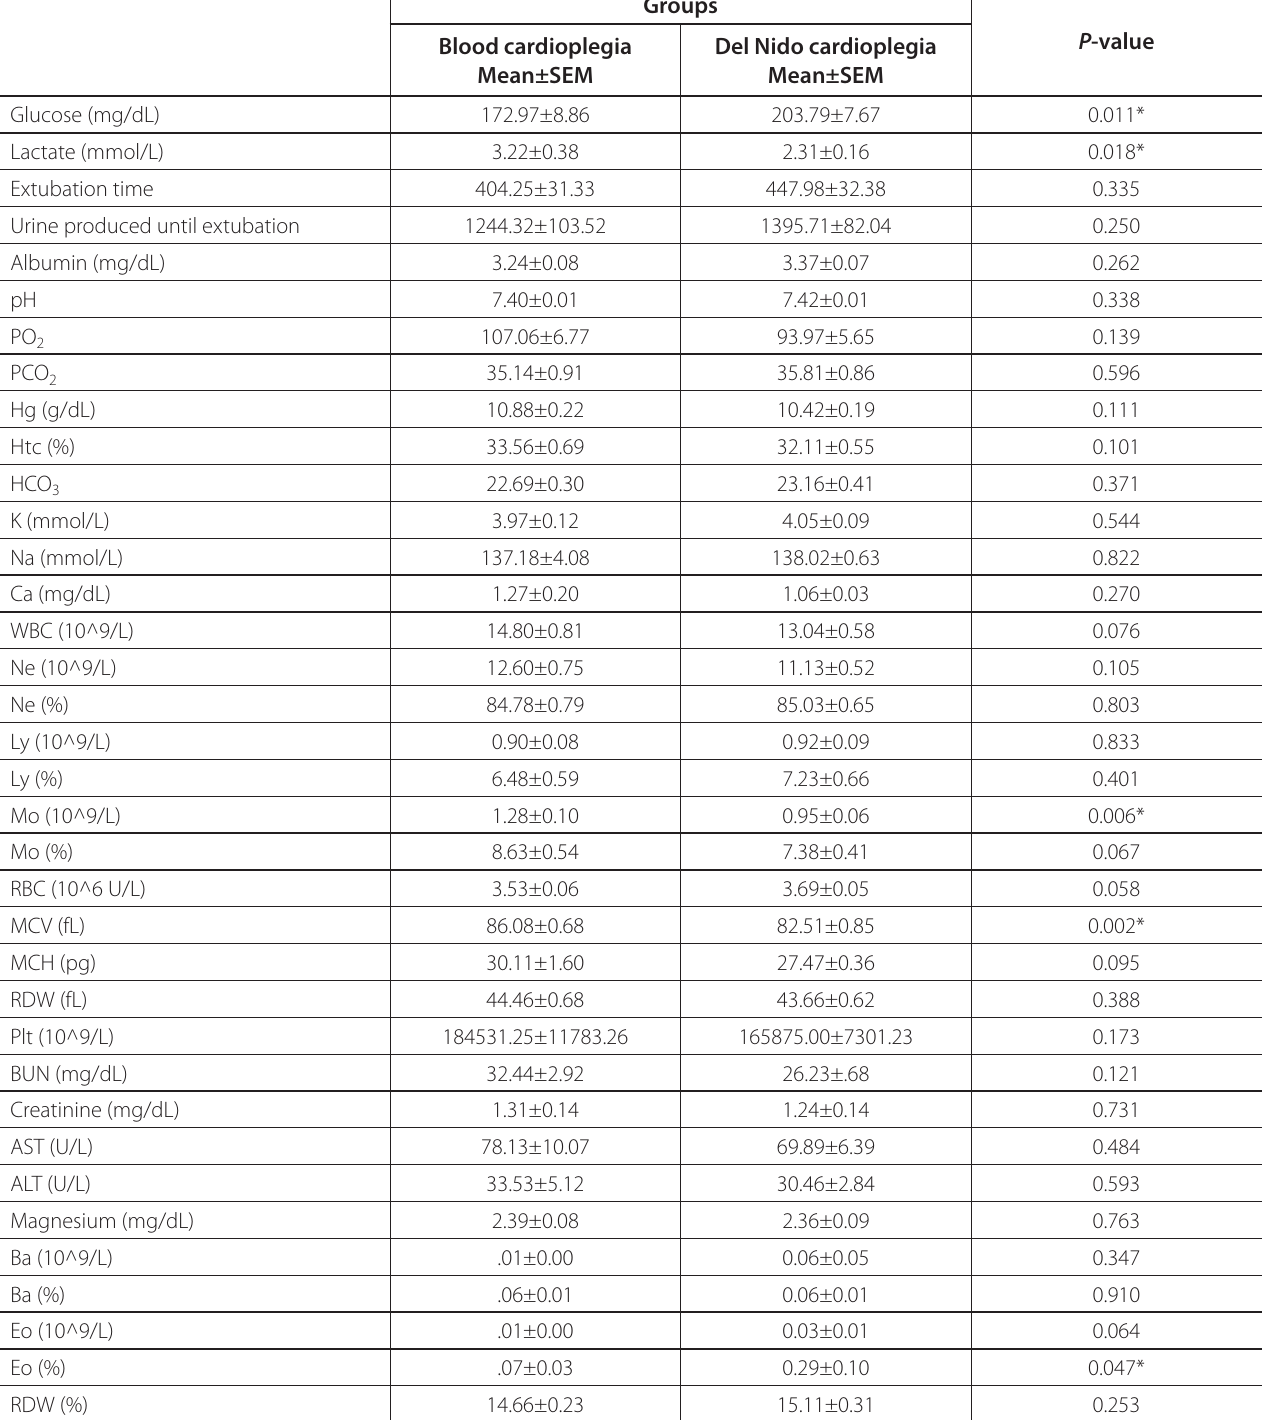
Table 5 . Distribution of the first biochemical and clinical parameters in the first 24 postoperative hours, by type of cardioplegia.